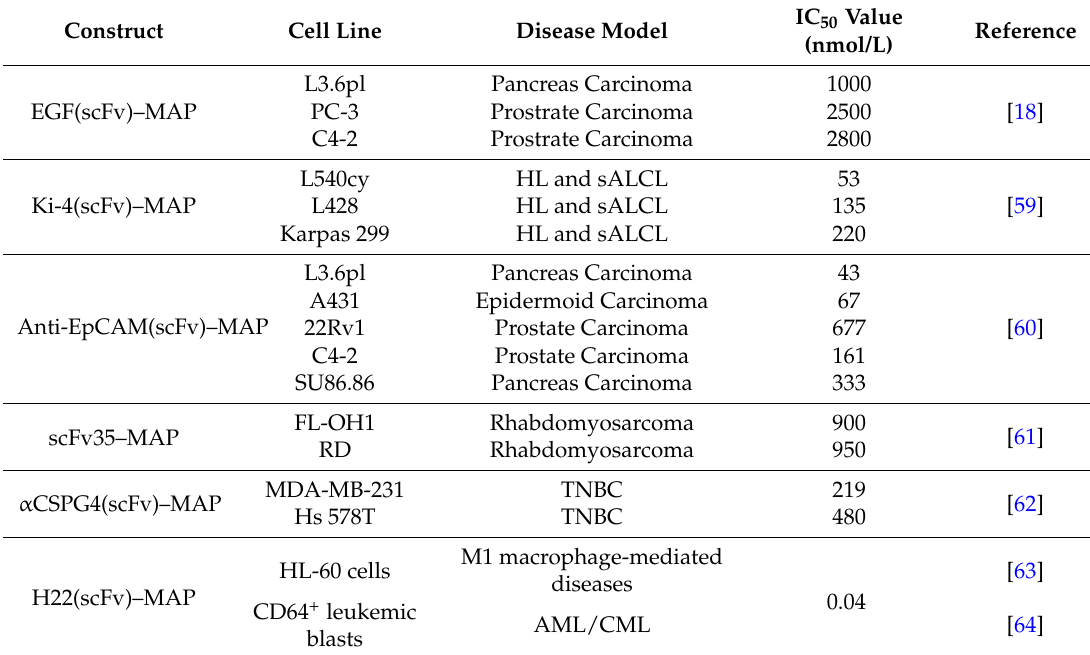
Table 1. Cytotoxicity of microtubule associated protein (MAP)-tau based human cytolytic fusion proteins to different cell